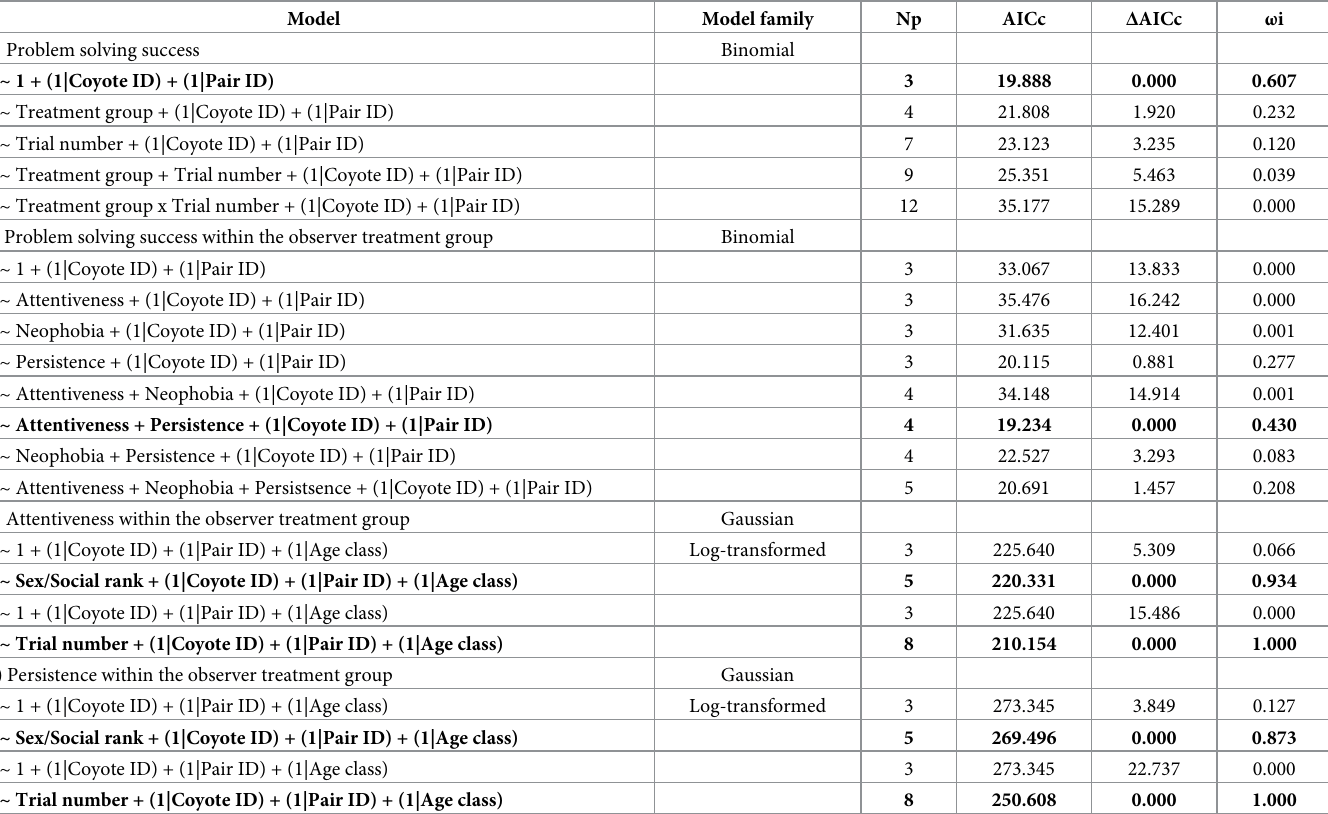
Table 4. Set of models fitted to assess the relationship between (A) problem solving success, treatment group, and trial number; (B) problem solving success within the observer treatment group and attentiveness, neophobia, and persistence; (C) attentiveness; and (D) persistence within the observer treatment group and sex, social rank, and trial number. The error distributions used in the models are specified by model family. Model comparison was based on AICc. Np is the number of parameters, Δ AICc is the difference between the candidate model and the model having the lowest AICc, and ω i is the AICc weight of each model. Models retained based on the lowest AICc value appears in bold, and models retained based on parsimony rules in italic